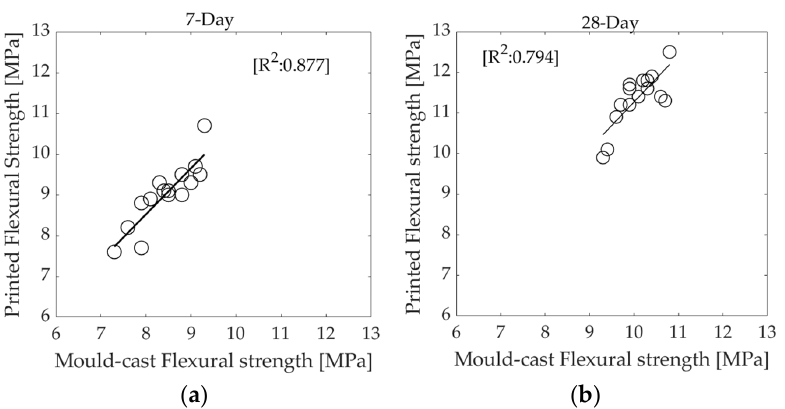
Figure 7. Showing correlation between mould ‐ cast and printed members for ( a ) flexural strength at 7 days, and ( b ) flexural strength at 28 days. Table 6 shows the average measured response of the four replicate mortars mixtures (Mix 17 to 20) prepared at the centre of the experimental domain, coefficient of variation, and half width of 95% confidence interval for each of the measured properties.